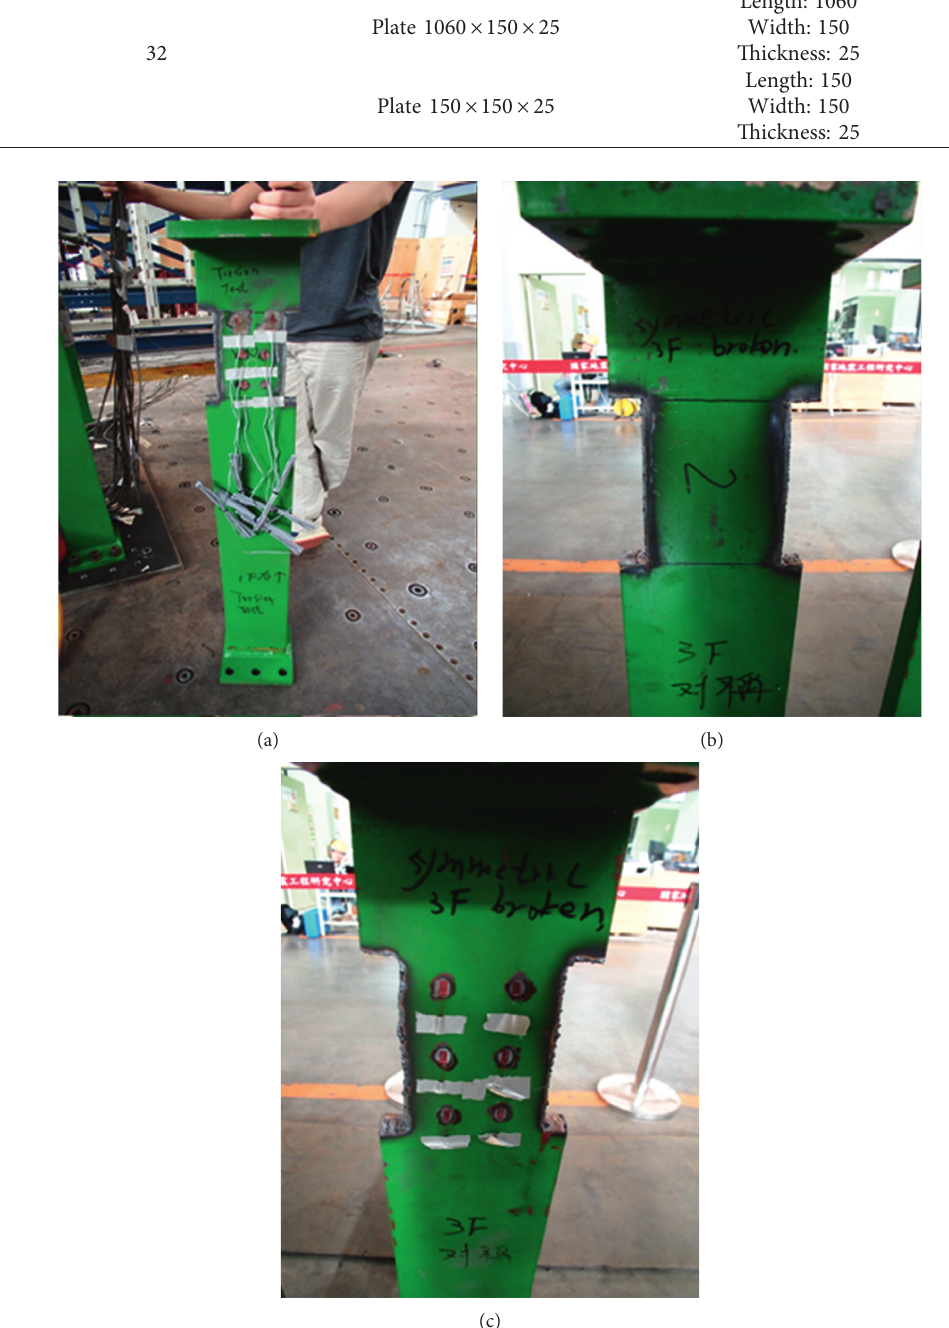
Figure 27: The damaged